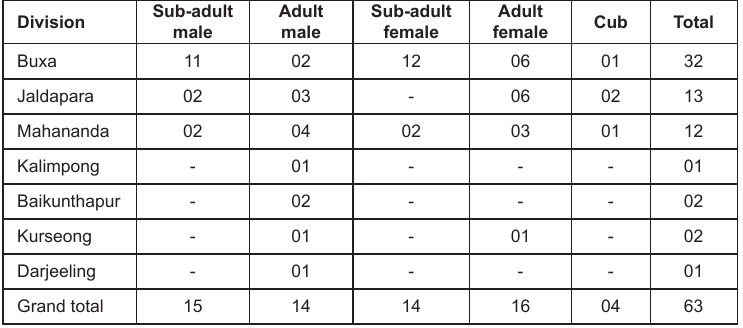
*Neora Valley population was not discovered during